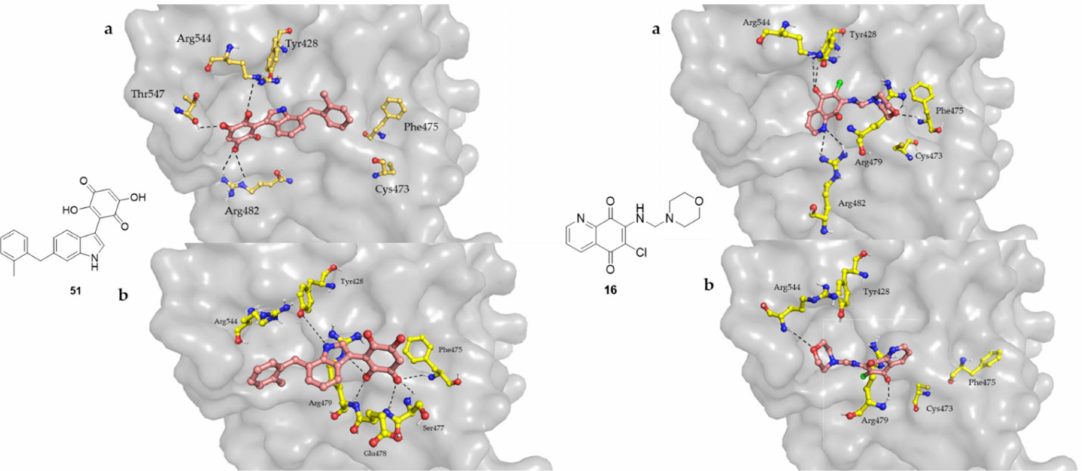
Figure 10. The binding modes of compounds 51 and 16 inside the binding groove of Cdc25B simulated by a AUTODOCK and b